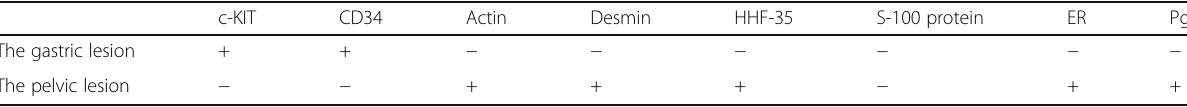
Table 1 Immunohistochemical comparison of GIST and DPL